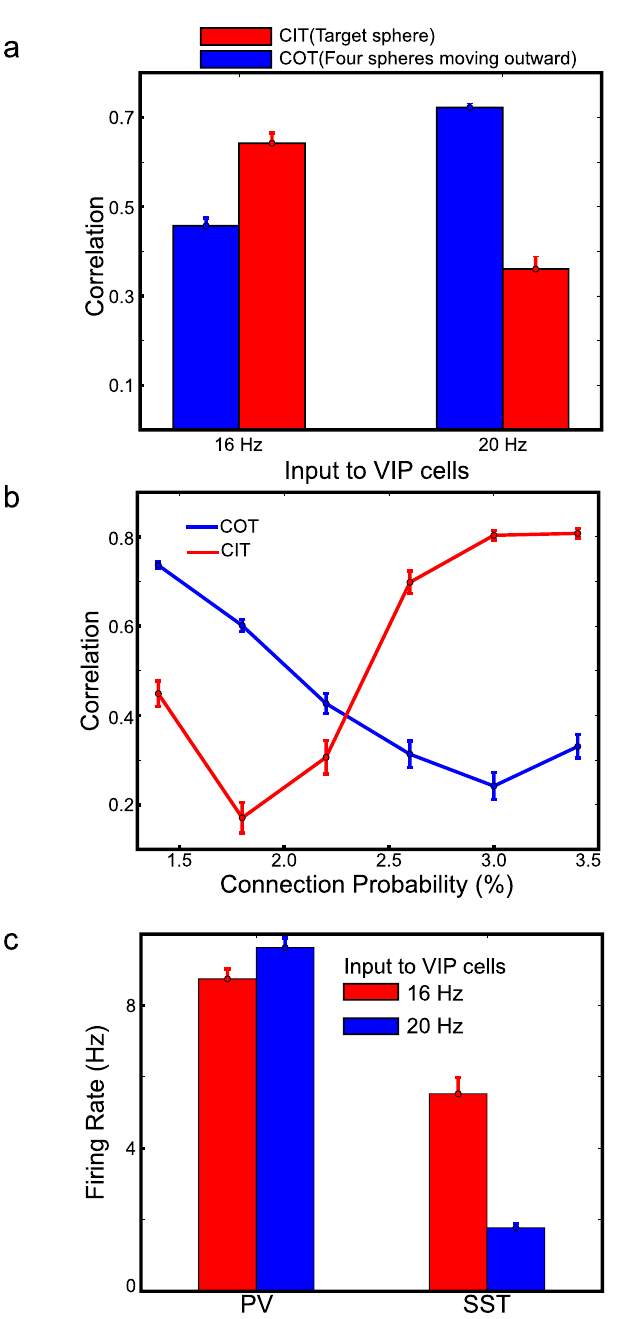
Figure 8. Correlations for the target and other spheres. ( a ) Correlations between high and low VIP cell depolarization conditions compared. ( b ) Dependency of correlations on the surround suppression strength regulated by connection probability for Pyr-SST connections across columns. ( c ) PV and SST cell activity between high and low VIP cell depolarization conditions. All error bars represent standard